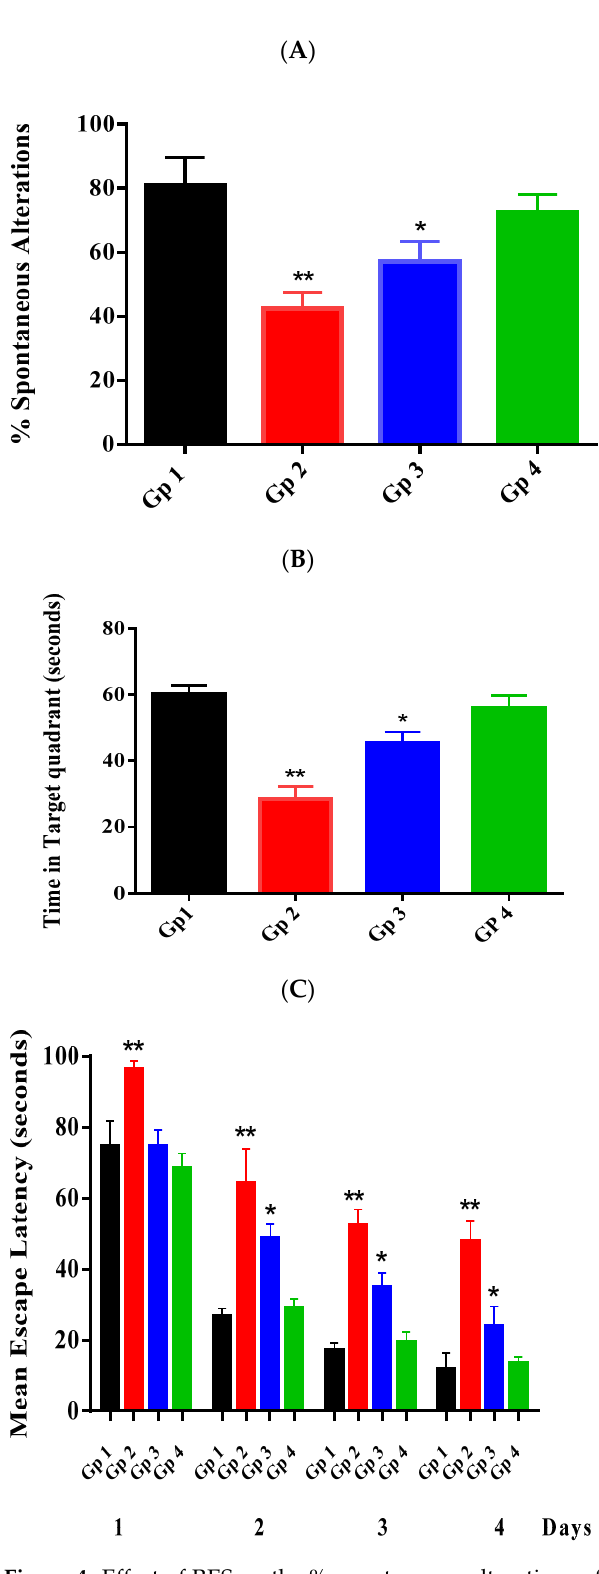
Figure 4. Effect of RES on the % spontaneous alterations of the Y-maze test ( A ), time spent in the target quadrant ( B ) in the MWM test, the escape latency ( C ) in the MWM test. Statistical analyses of the mean percentage of results were performed using one-way analysis of variance (ANOVA) ( p < 0.05), followed by the Tukey–Kramer post hoc test, whereby each value was presented as mean ± standard deviation of the mean, where (*) and (**) indicate statistically different values from the control group at ( p < 0.05, and p < 0.01),